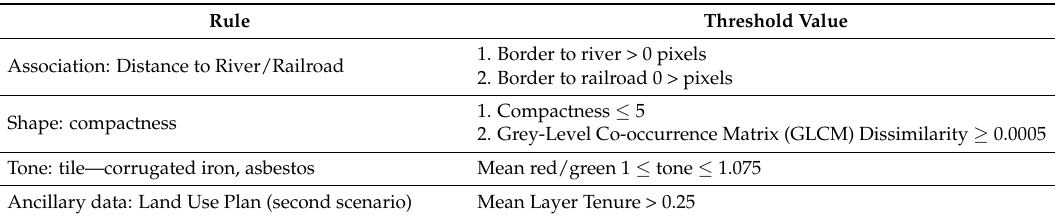
Table 3. Threshold value for each rule.